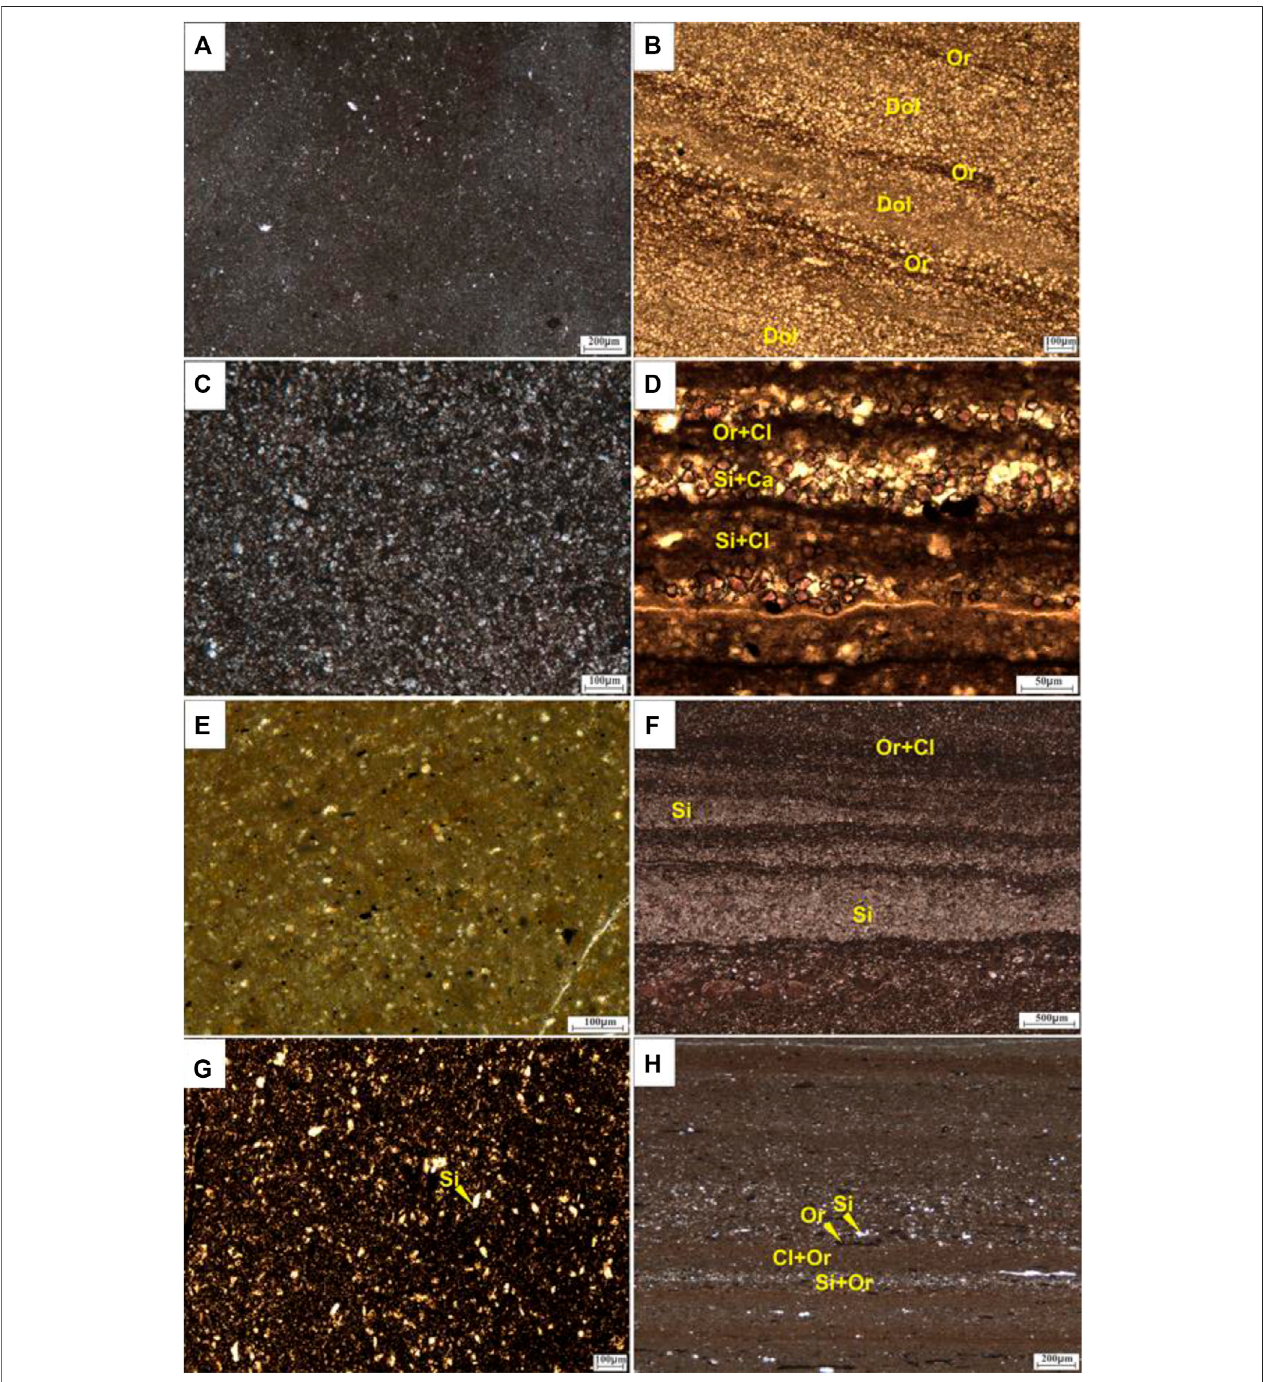
FIGURE9| Thin sections and SEMimages ofshalesamples. Borehole locations areavailable in Figure1B . (A) Thin-section photograph ofthesamplefrom GD-Y well, 4138.2 m, lithofacies: C-1. (B) Thin-section photograph of the sample from G-X well, 2943.64 m, lithofacies: C-2. (C) Thin-section photograph of the sample from GD-Ywell,4111.44 m,lithofacies:C-3. (D) Thin-sectionphotographofthesamplefromG-Xwell,3187.53 m,lithofacies:S-2. (E) Thin-sectionphotographofthesample from GD-Y well, 2929.04 m, lithofacies: S-1. (F) Thin-section photograph of the sample from GD-Z well, 3854.94 m, lithofacies: S-3. (G) Thin-section photograph of the sample from GD-Z well, 3858.2 m, lithofacies: M-1. (H) Thin-section photograph of the sample from G-X well, 2991.9 m, lithofacies: M-2. Or, organic matter; Cl, clay minerals; Si, quartz + feldspar; Ca, calcite; Dol, dolomite.